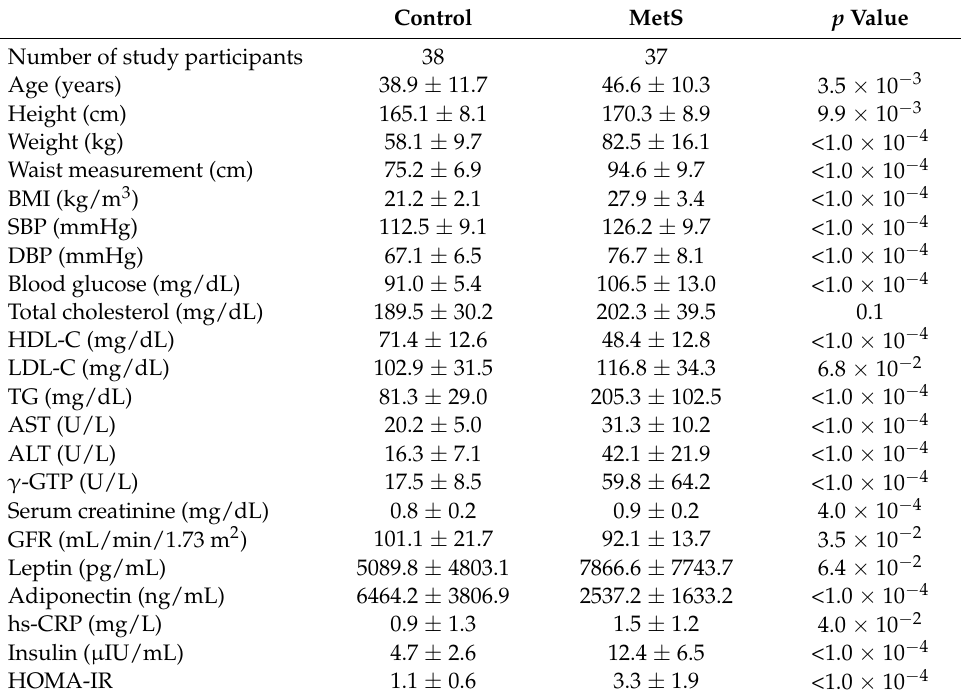
Table 1. Clinical characteristics of study